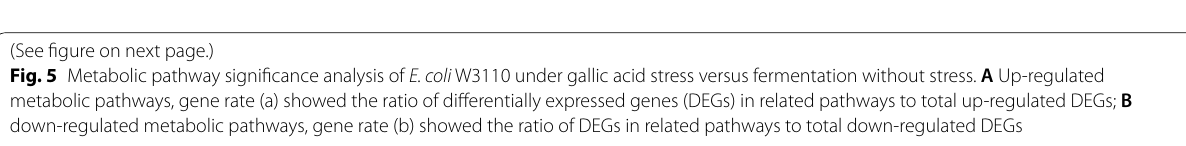
DEGs(See figure on next Fig. 5 Metabolic pathway significance analysis of E. coli W3110 under gallic acid stress versus fermentation without stress. A Up-regulated metabolic pathways, gene rate (a) showed the ratio of differentially expressed genes (DEGs) in related pathways to total up-regulated DEGs; B down-regulated metabolic pathways, gene rate (b) showed the ratio of DEGs in related pathways to total down-regulated